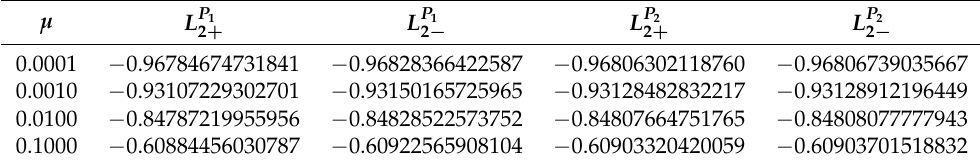
Table 2. Equilibrium solution of R2+2BP near L 2 .